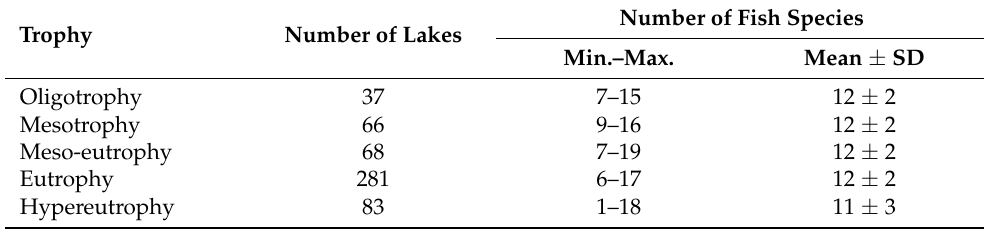
Table 2. The number of lakes and the number of fish species in different trophic types. Trophic conditions of the studied lakes were based on the trophic state.index (TSI) of lakes, calculated from Secchi discvisibility according to Carlson [24]. SD = standard